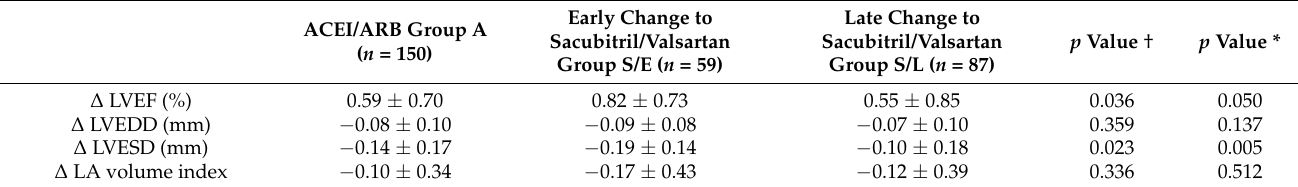
Table 4. Changes in echocardiographic parameters from the initial diagnosis to the last